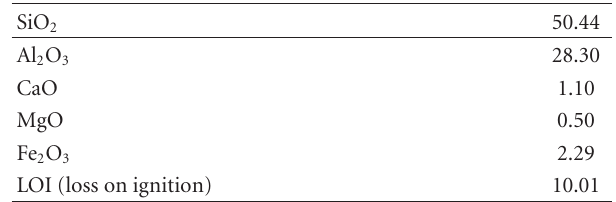
Table 1: Chemical composition (wt%) of the used